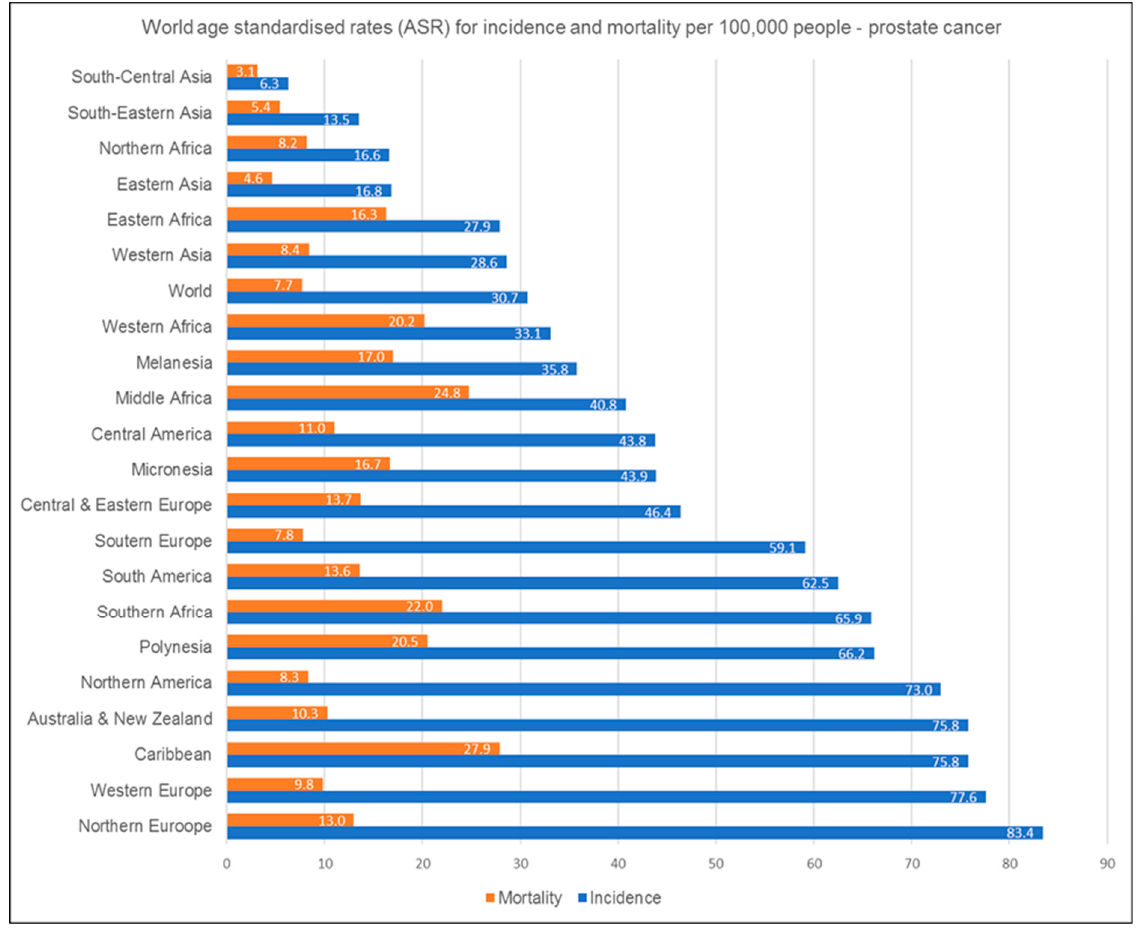
Figure 1. World prostate cancer incidence and mortality rates per 100,000 people. ASR stands for age-standardised rates, adapted from Globocan, 2020 [1].